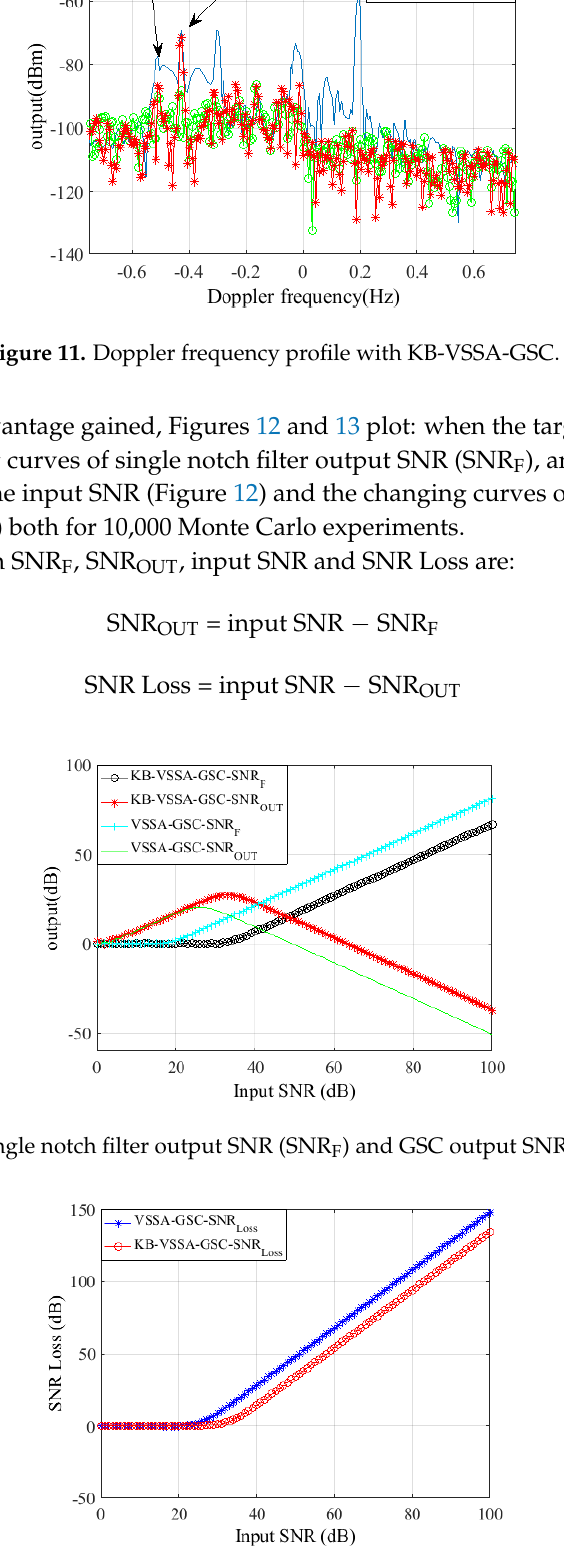
Figure 13. SNR loss of VSSA-GSC and KB-VSSA-GSC